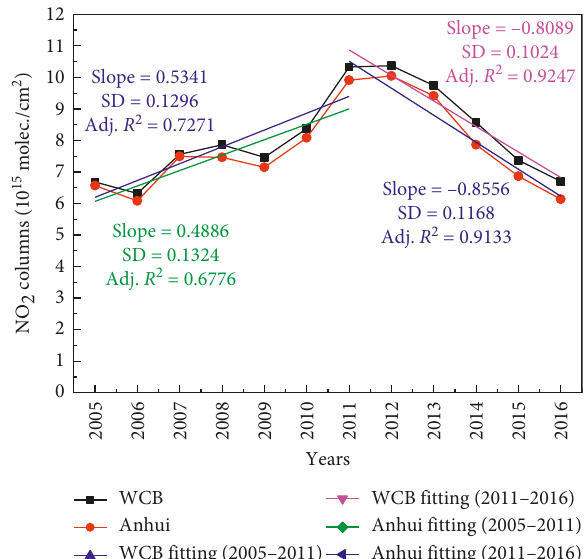
Figure 9: Average tropospheric NO Anhui and WCB.